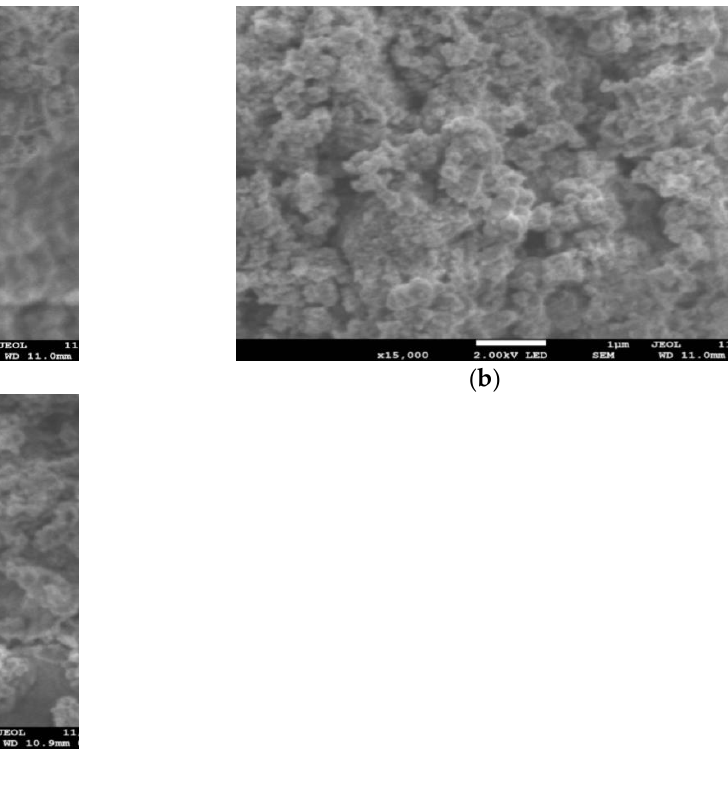
Figure 6. SEM images of flocs ( a ) PAC ( b ) PAC+PAM ( c ) magnetic flocculation.